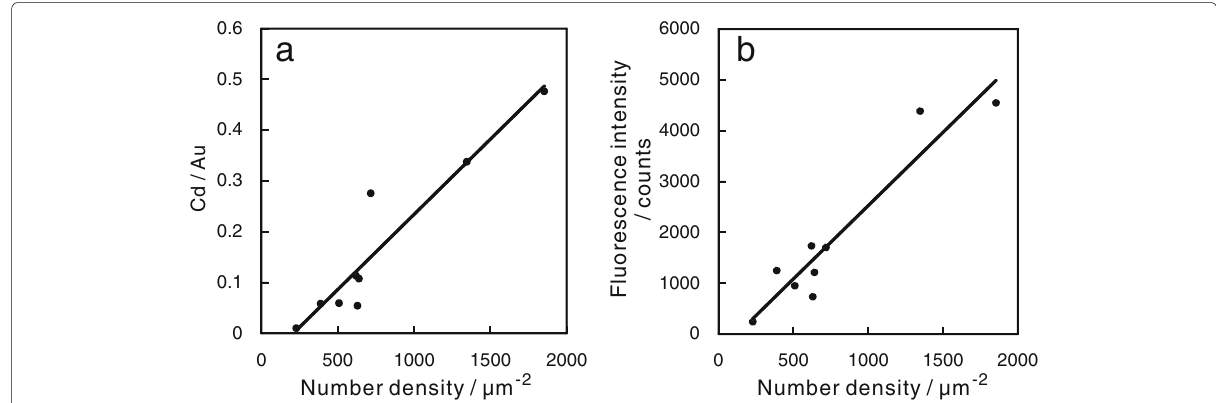
Fig. 4 a Number density of QDs and atomic ratio of Cd/Au. b Number density of QDs and fluorescence intensity